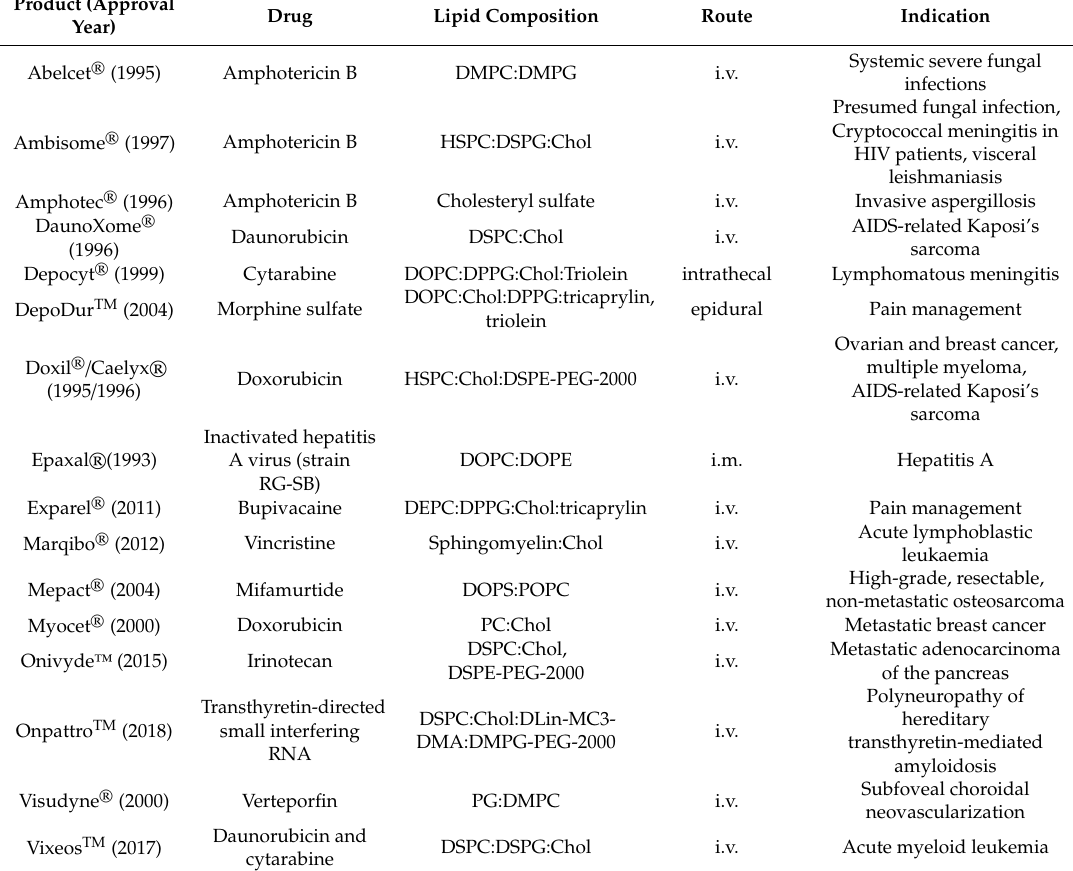
Table 2. Liposomal formulations approved for clinical